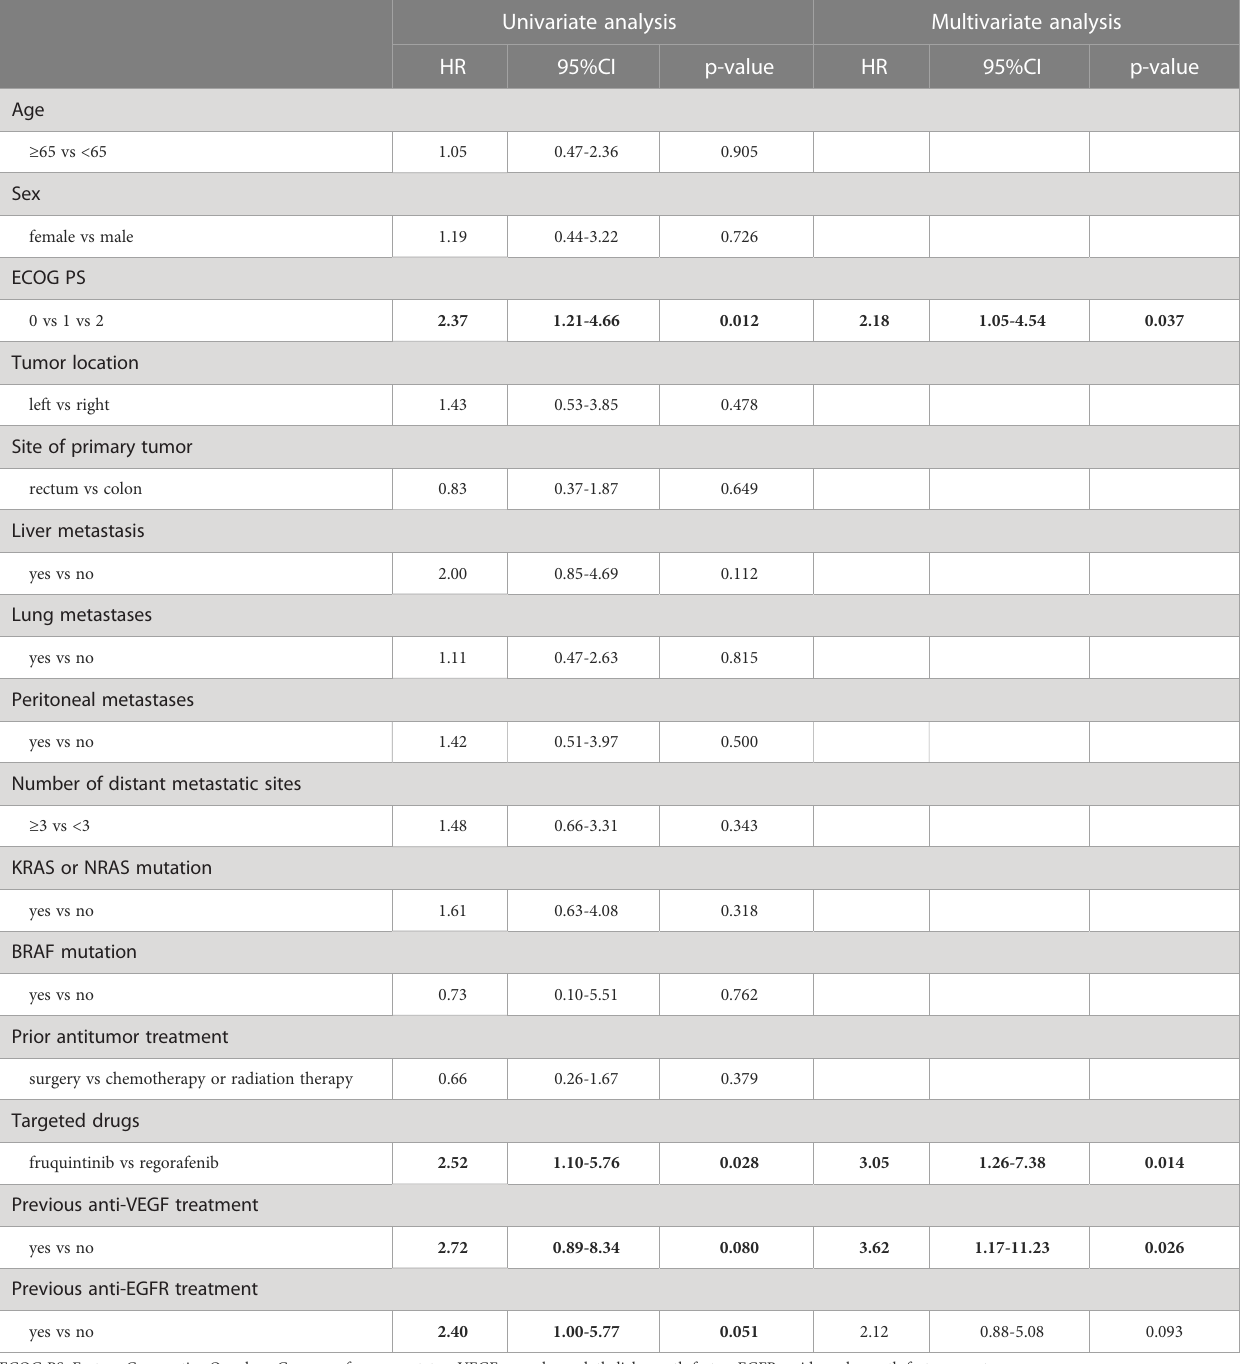
TABLE 4 Univariate and multivariate analyses of risk factors for PFS of FP and